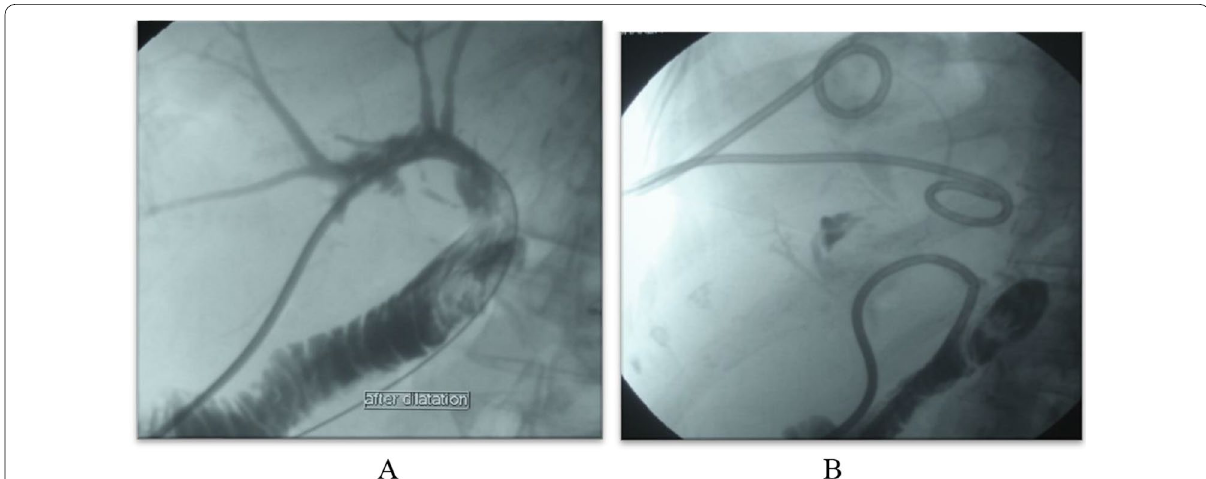
Fig. 19 A well‑placed internal/external drain with opacification of the bowel loops denoting proper drainage ( A ), with two drainage pigtails for the abscesses ( B